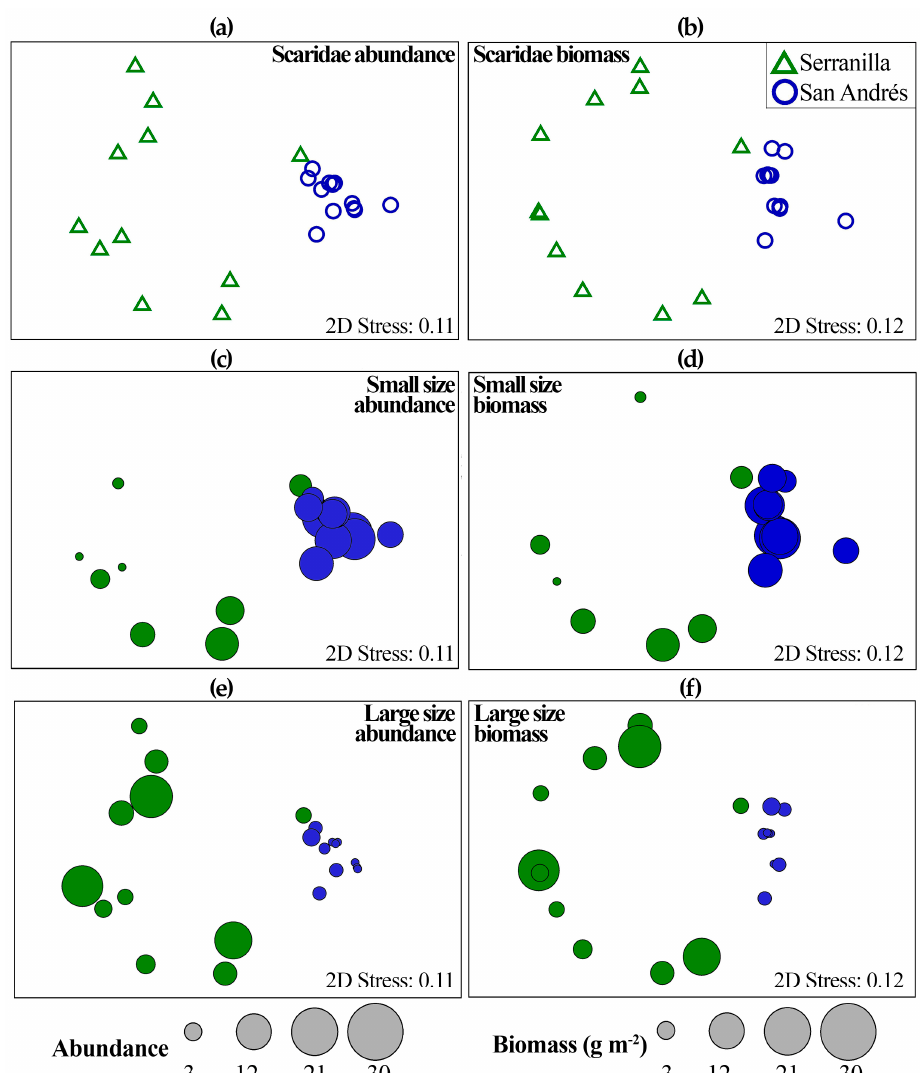
Figure 2. Non-metric multidimensional scaling (NMDS) plots of parrotfish abundance and biomass at sites at Serranilla and at San Andrés. Plots of abundance are shown for ( a ) all parrotfish, ( c ) small-size parrotfish (<50 cm), and ( e ) large-size parrotfish (>50.1 cm). Corresponding plots of biomass are shown for ( b ) all parrotfish, ( d ) small-size parrotfish, and ( f ) large-size parrotfish. Bubble sizes indicate the abundance or biomass values for each site.